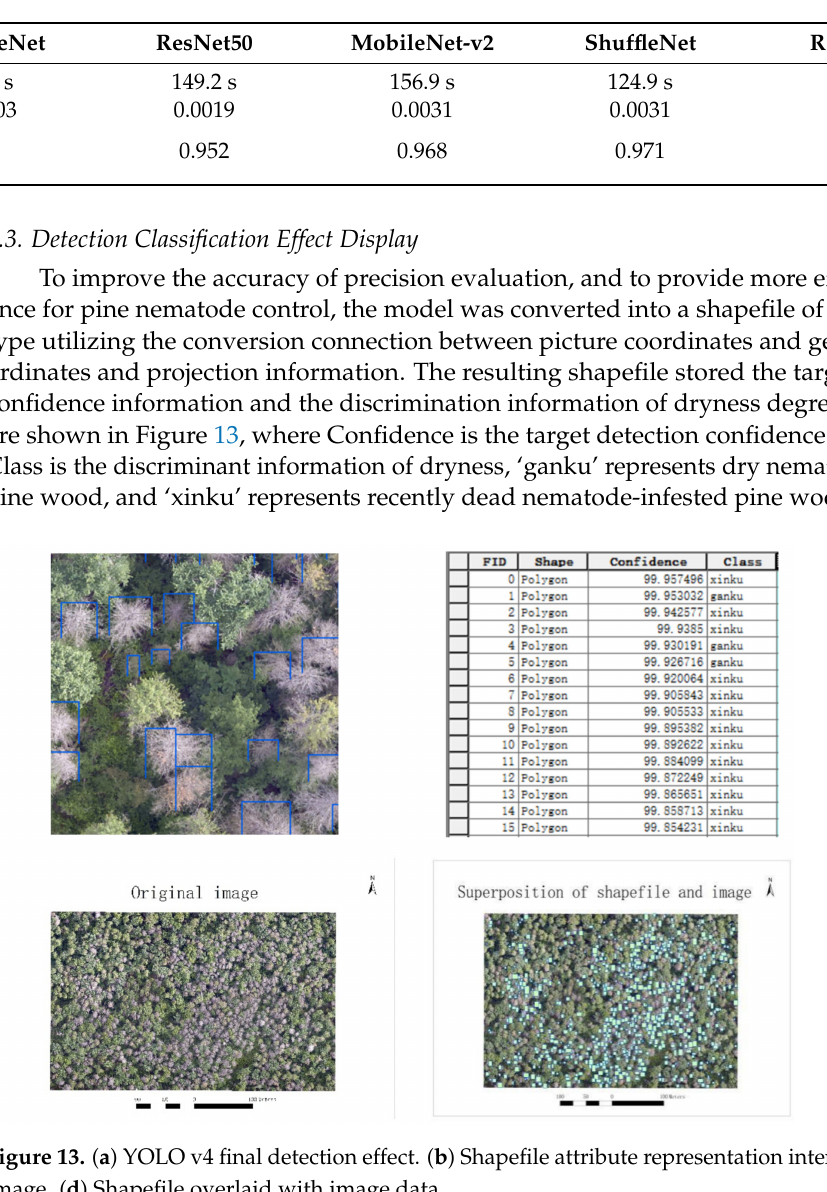
Table 6. Recognition classification model performance comparison table.